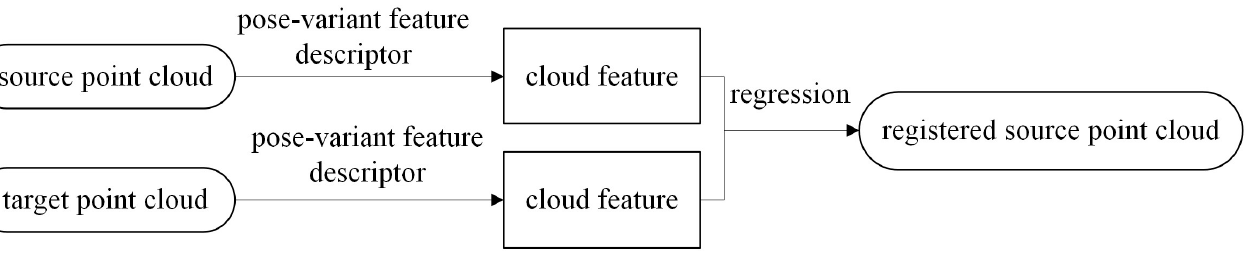
Figure 5. The pipeline of the registration that is based on pose ‐ variant features.